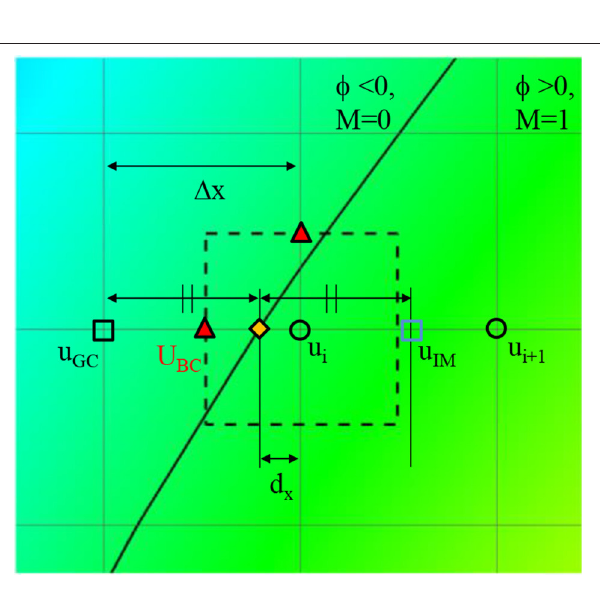
FIGURE 4 | A schematic describing the imposition of wall boundary condition. The rectangle with dashed line represents a computational cell. Triangle symbol indicates the cell face center where the boundary velocity, U BC is imposed. Detailed description is provided in the